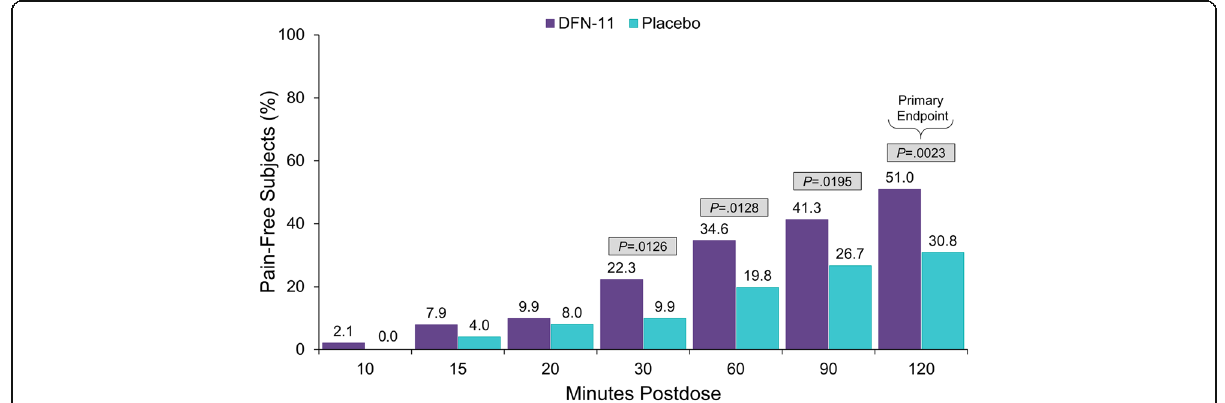
Fig. 2 Proportion of subjects with pain freedom through 2 h